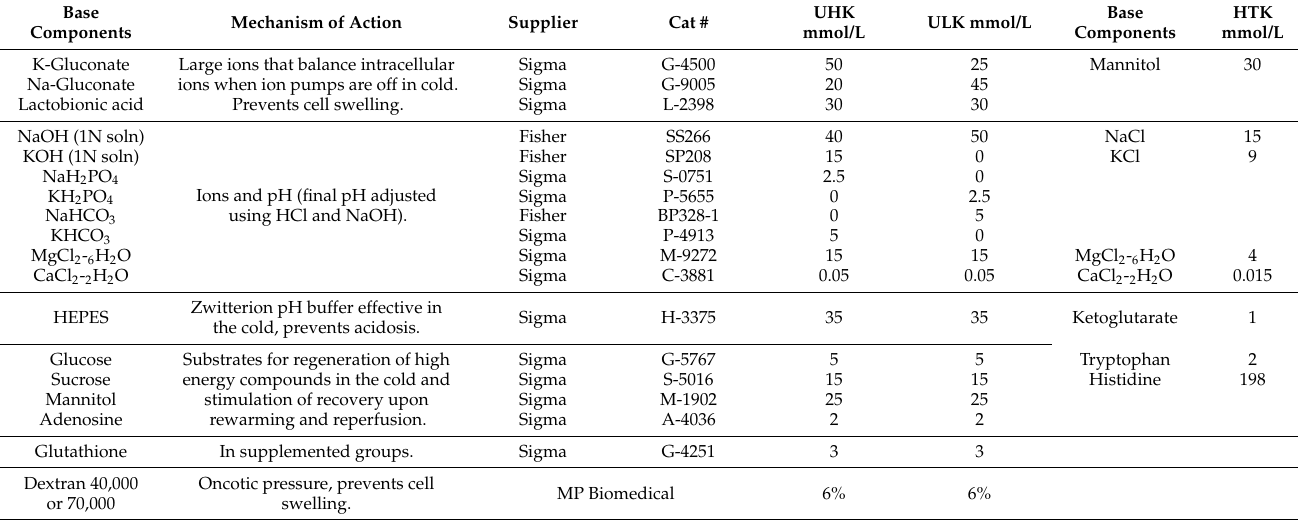
Table 1. Gluconate-lactobionate-dextran (Unisol) perfusion solutions: formulations and mechanisms of Action (350 mOsmoles and pH 7.6) in comparison to HTK.